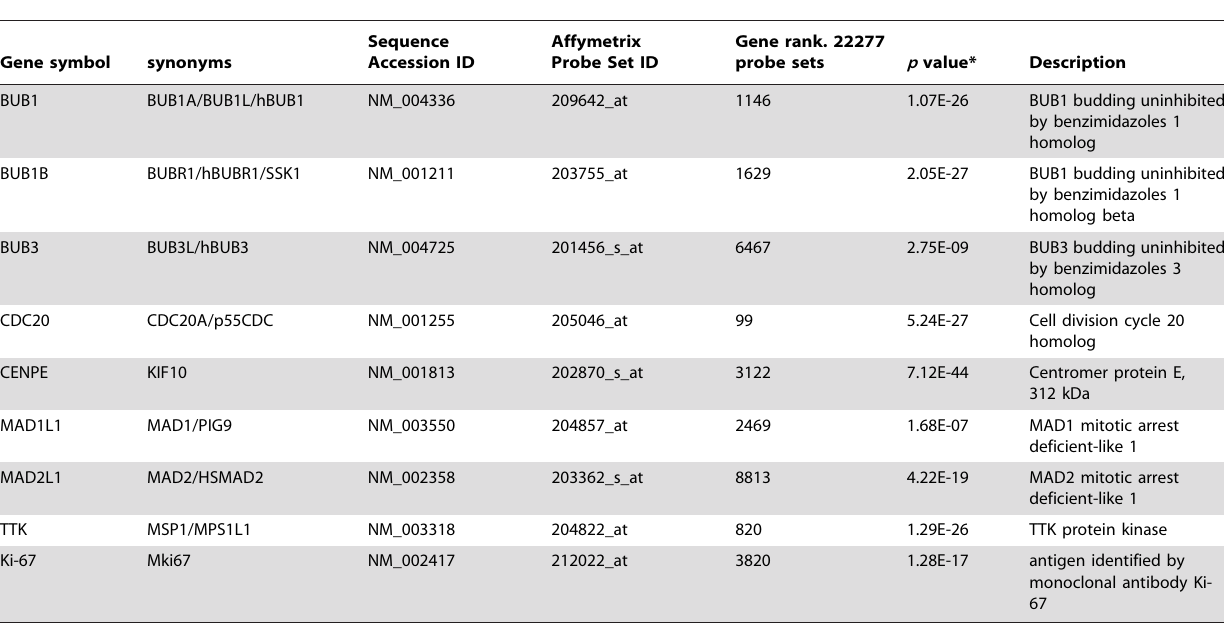
Table 2. Correlation of SAC gene expression with glioma grade using four independent Affymetrix GeneChip datasets.